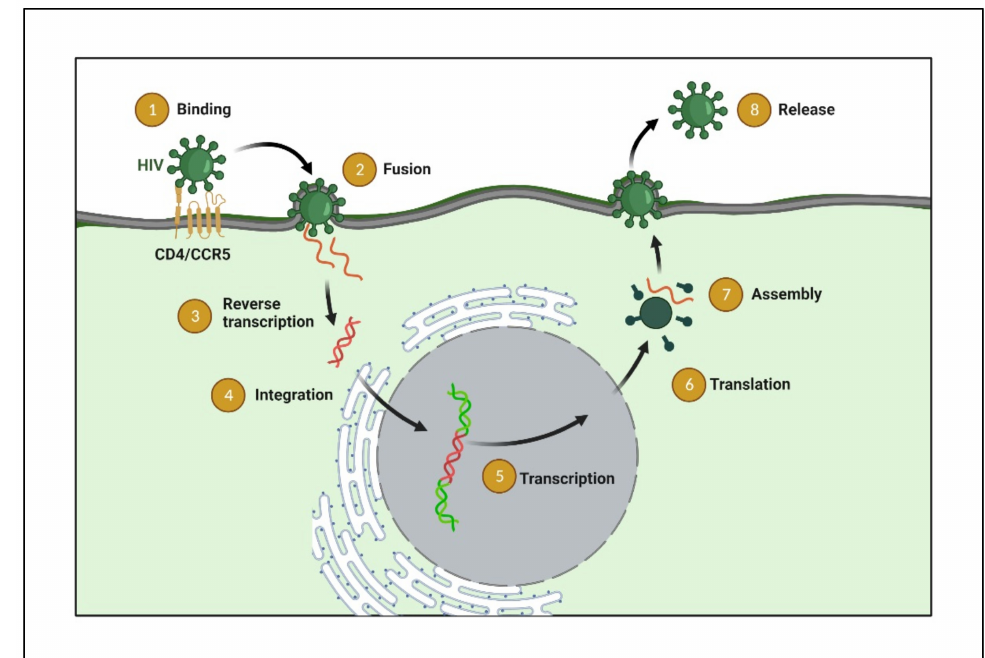
Figure 2. Infographic illustration of the HIV replication cycle begins with the fusion of HIV with the host cell surface, leading to the entry and release of the virus’s genome and proteins in the form of a capsid. The capsid shell disintegrates, and the HIV reverse transcriptase transcribes the viral RNA into DNA. The viral DNA is transported across the nucleus and integrated into the host’s DNA via the HIV protein integrase. It utilizes the host’s normal transcription machinery to transcribe the HIV DNA into multiple new HIV RNA copies. This RNA can be packaged as a new virus genome or utilized by the cell to make new HIV proteins. The new viral RNA and HIV proteins translocate to the cell surface to form a new, immature HIV virion. Finally, the HIV protease cleaves these newly translocated polyproteins to create a mature infectious virus released from the cell; different stages can be an intervention site for different ARTs. (Created with BioRender.com (accessed on 19 June